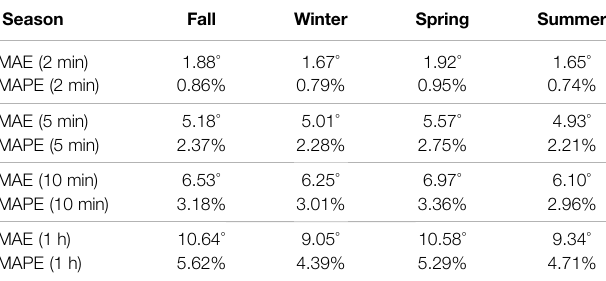
TABLE 3 | Angular prediction error at four